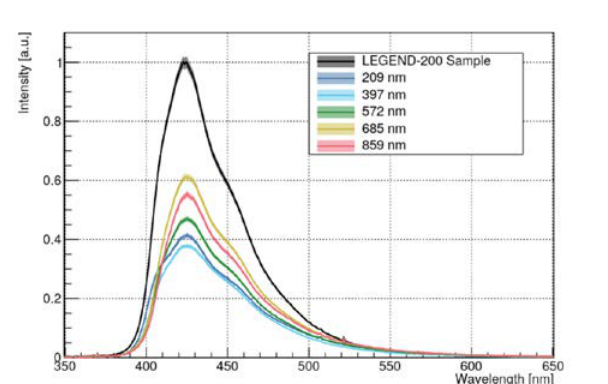
Fig. 5. Photoluminescence spectra under 128 nm excitation for a WLSR sample as well as Tetratex samples evaporated with TPB at different